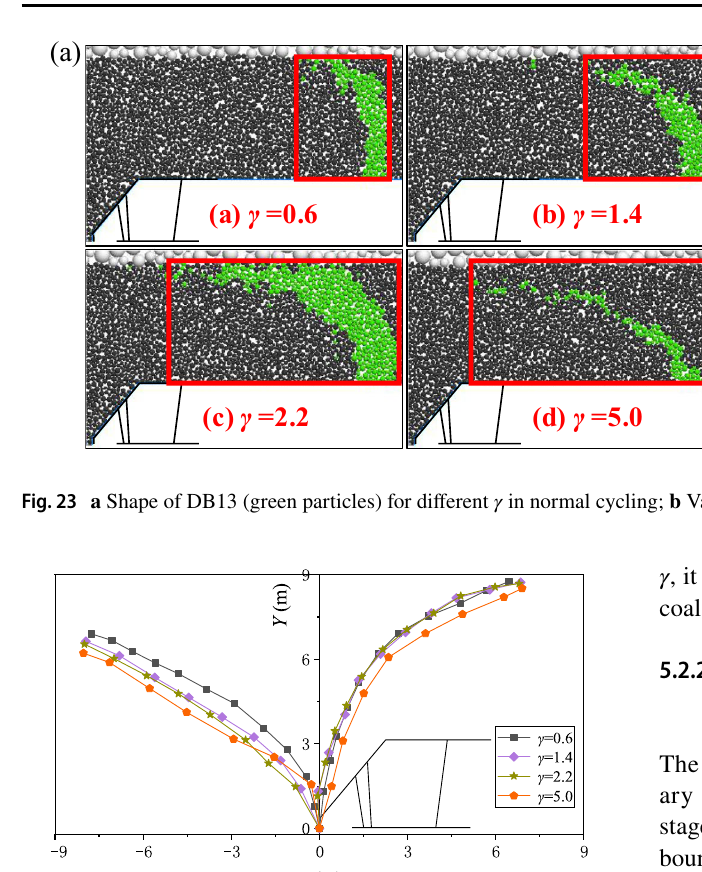
Fig. 24 Initial top-coal boundary for different γ